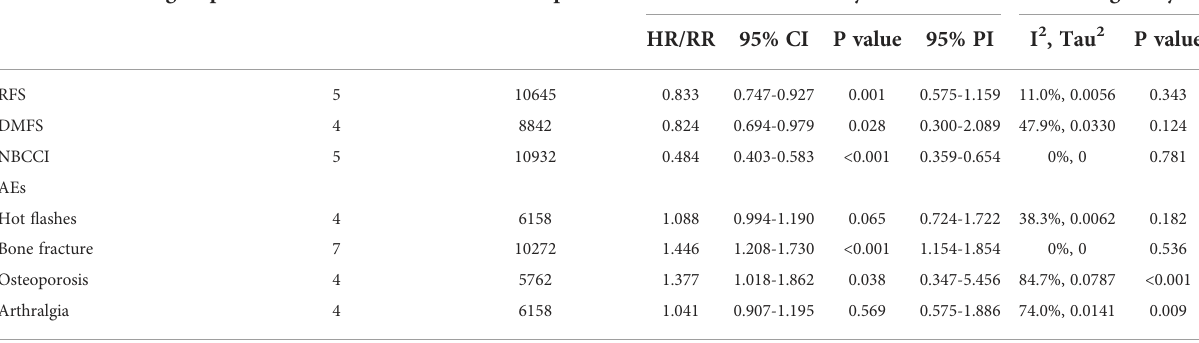
TABLE 4 Meta-analysis of RFS, DMFS, NBCCI and AEs for extended versus routinely endocrine treatment in HR+ early breast cancer. Outcome and subgroups Number of studies Number of